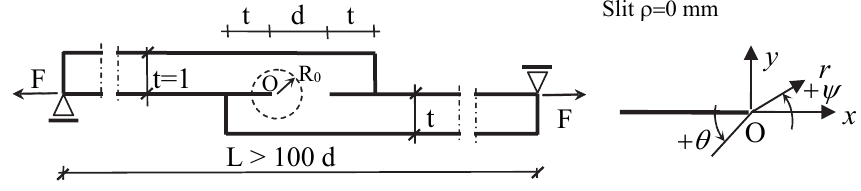
Figure 1. Geometry of the welded lap joint